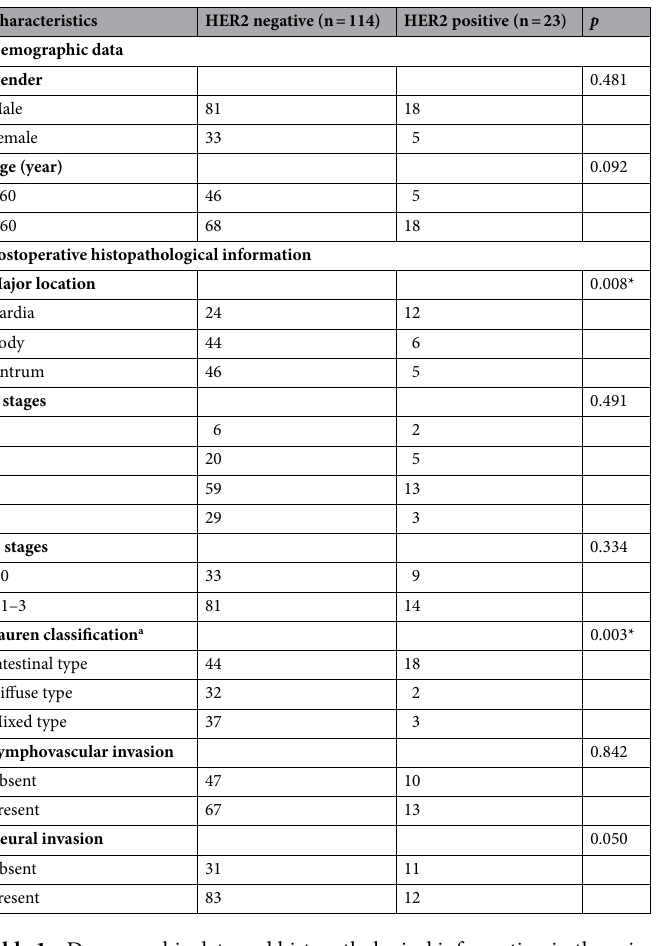
Table 1. Demographic data and histopathological information in the primary cohort. HER2 human epidermal growth factor receptor 2. a Not applicable for one patient; * p < 0.05 with chi-square test or Fisher’s exact test (n <